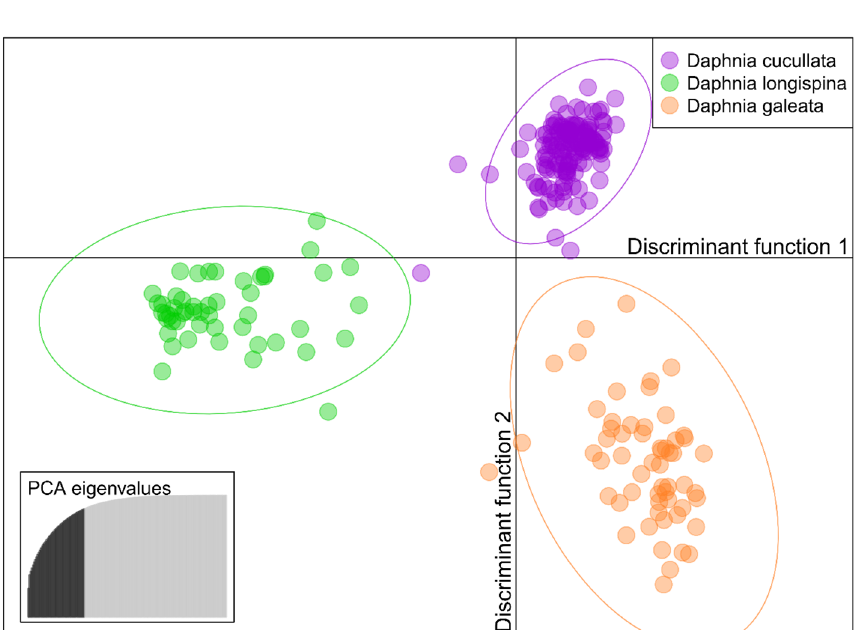
Figure 2. Results of Discriminant Analysis of Principal Components (DAPC), which clustered Daphnia genotypes inferred with microsatellite markers into three groups. Daphnia genotypes from contemporary samples from heated and control lakes and resting eggs from the heated lake MI were analysed together. Each dot represents one individual; inertia ellipses around groups are also presented. The inset plot presents PCA eigenvalues; those retained in the dimensional reduction step are indicated with